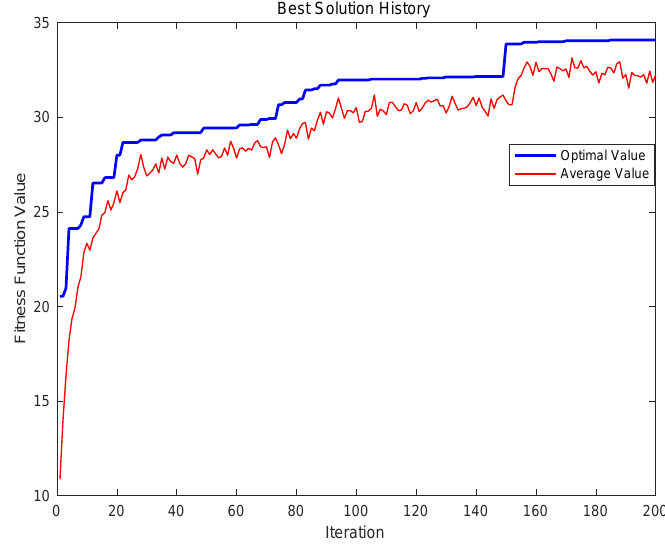
Figure 6. Evolution results of PGA with 60 attractions. Table 8. Results of the satisfaction route with PGA (60 attractions)